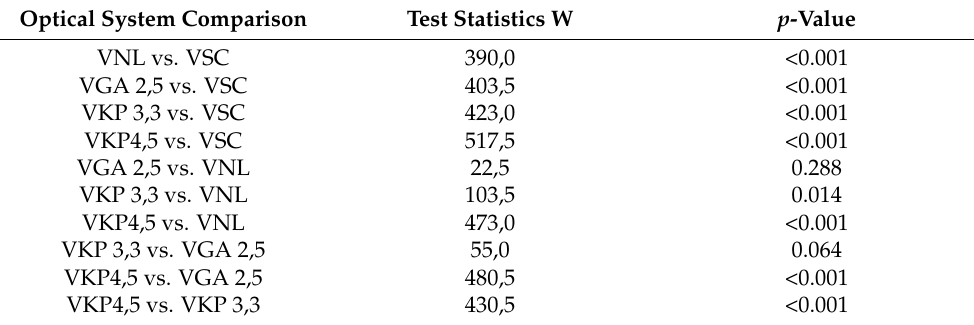
Table 2. Wilcoxon Signed Rank test results to compare visual acuity recorded when using different optical systems *. Optical System